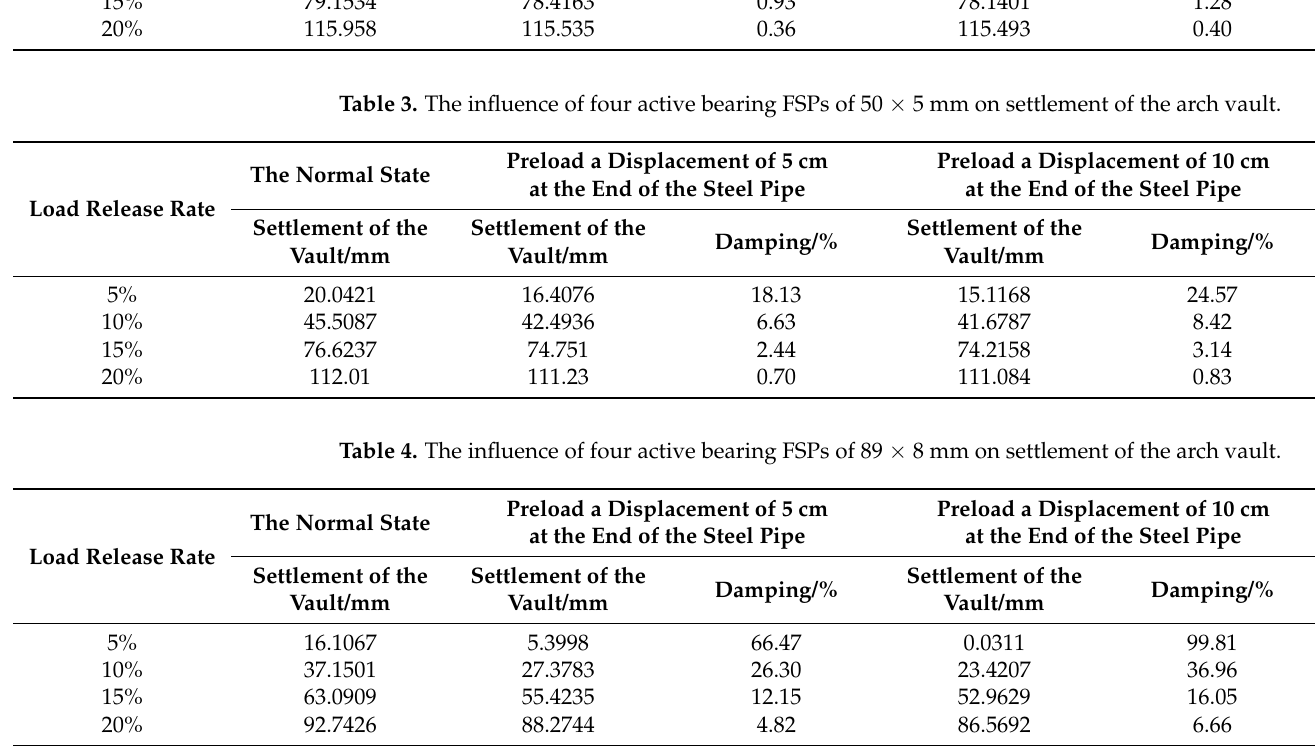
Table 5. The influence of two active bearing FSPs of 89 × 8 mm on settlement of the arch vault.